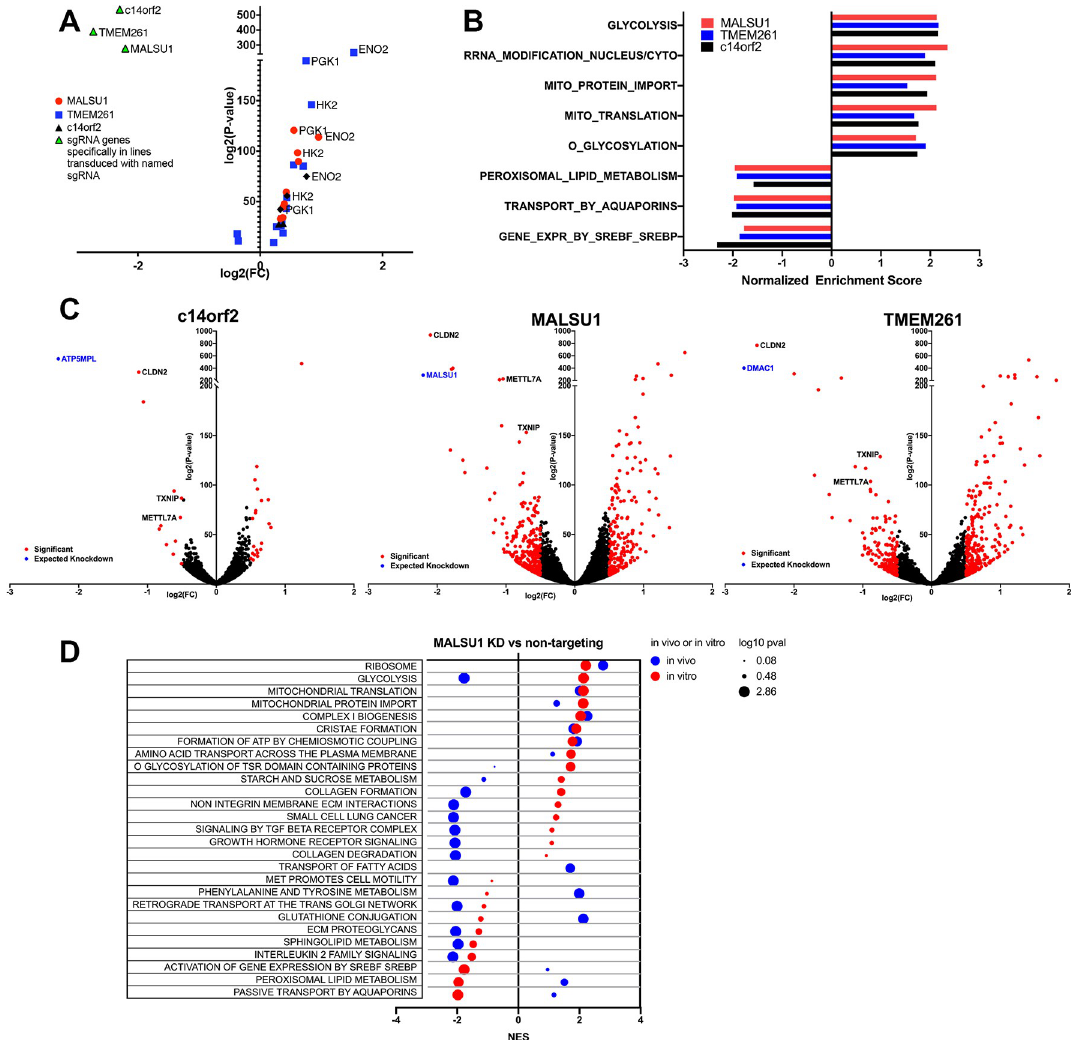
Fig 2. Transcriptome profiling of human lung cancer cells expressing sgRNAs against mito-respiratory hits reveals overexpression of glycolytic pathway genes in vitro and repression in vivo. RNA-Seq was performed on HCC827 cells expressing individual sgRNA against top hits c14orf2 , MALSU1 , TMEM261 (or control sgRNA) ( n = 4 samples per cell line) to determine changes in gene expression in vitro and in vivo. ( A) Averaged expression for each mito-respiratory sgRNA was compared to control cells, fold- change, indicated by log2(FC) plotted on the x-axis, and log2( p -value) on the y-axis. SgRNA-targeted genes are indicated by green triangles, with each cell line demonstrating the expected reduced expression of its targeted gene (upper left quadrant). Glycolytic genes were the most overexpressed genes overall, with ENO2 , PGK1 , and HK2 being the most overexpressed genes across all 3 cell lines. ( B) Gene set enrichment analysis identifies glycolysis and mitochondria-associated pathways and ontologies as enriched in all 3 cell lines. Significance was set at p < 0.05. ( C) Volcano plots shown for each of the single sgRNA cell lines. Expected sgRNA-mediated silencing was observed in all 3 cell lines (blue dot). ( D) HCC827 cells transduced with either control sgRNA or MALSU1 sgRNA were injected into the flanks of nude mice, then grown for 28 days, after which tumors were removed and analyzed by RNA-Seq. Pathway analysis was performed comparing the MALSU1 sgRNA cells to control sgRNA cells grown in vivo (blue) or in vitro (red), and displayed in a bubble plot indicating normalized enrichment score (NES) and log 10 p -value for significantly altered pathways. Control sgRNA tumors n = 4, sgMALSU1 tumors n = 2. Underlying data can be found in S1 Data.